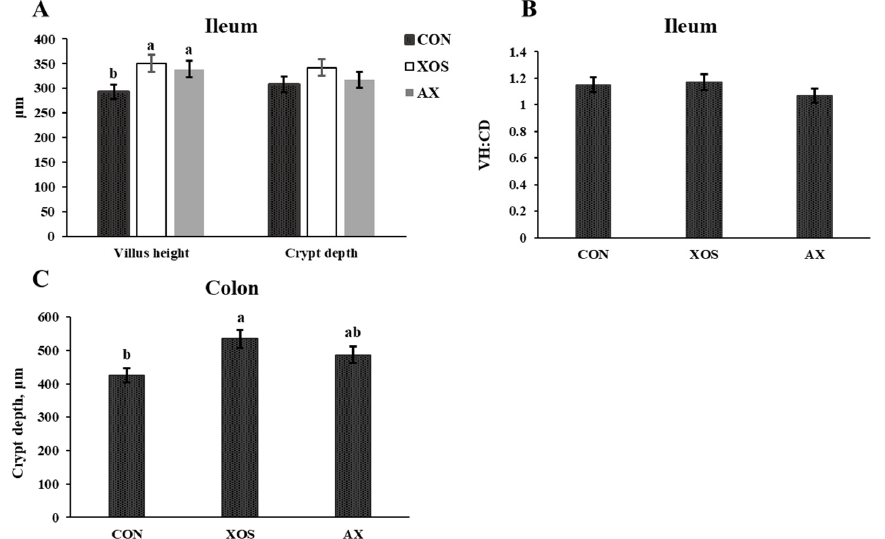
Figure 2. Effects of xylo-oligosaccharides and arabinoxylans on apparent total tract digestibility of dietary nutrients in weaned pigs. Note: a,b significant differences ( p < 0.05) between different letters in the same row of shoulder labels (n = 6); CON, a control diet; XOS, a diet containing 1% xylo- oligosaccharide; AX, a diet containing 1% arabinoxylans; SEM, standard error of the mean. DM, dry matter; GE, gross energy; CP, crude protein; NDF, neutral detergent fiber; ADF, acid detergent fiber.